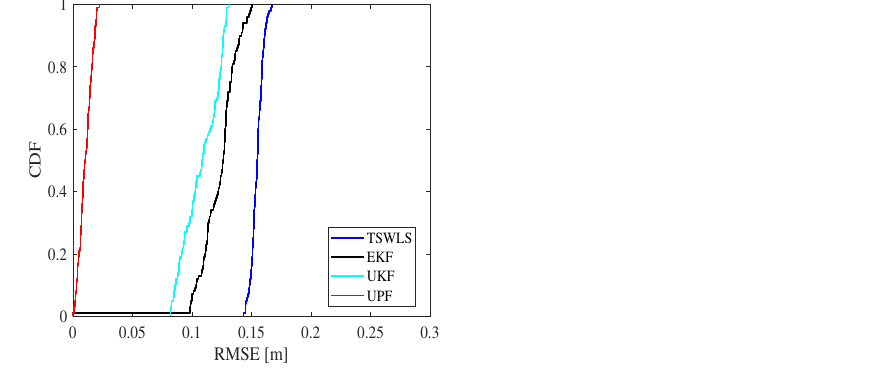
Figure 5. The CDF of RMSE for different methods in NLOS scenario ( σ θ